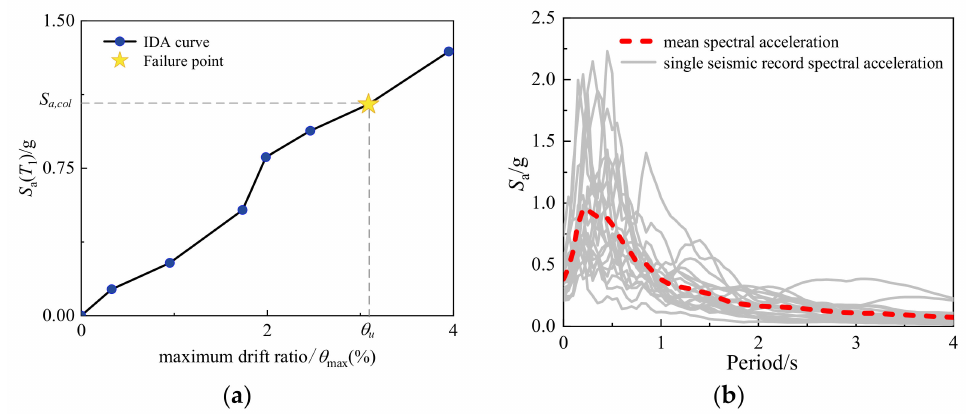
Figure 3. Schematic diagram of the IDA curve and spectral acceleration response of the selected ground motions. ( a ) Schematic diagram of the IDA curve; ( b ) Spectral acceleration response of the selected ground motions.